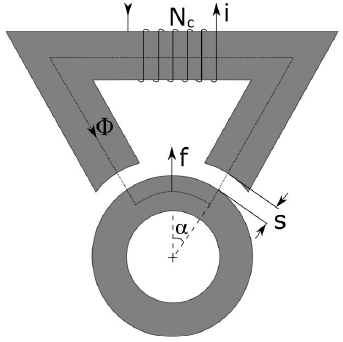
Figure 3. Force and geometry of a single AMB